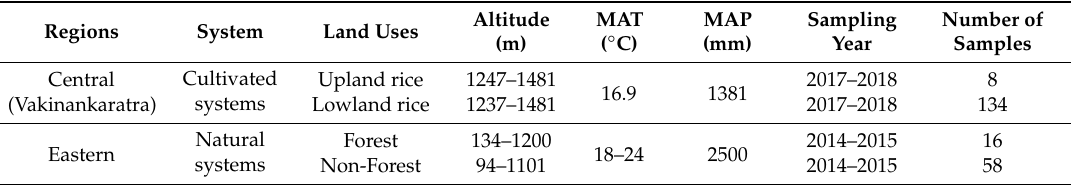
Table 1. Spatial characterization of the soil sample used for the study.